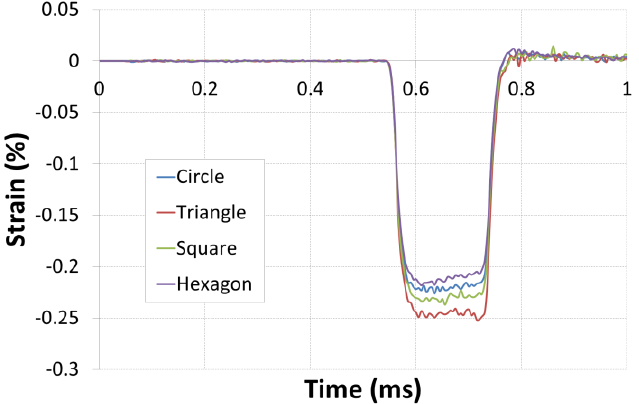
Figure 12. Axial deformation of the specimen.